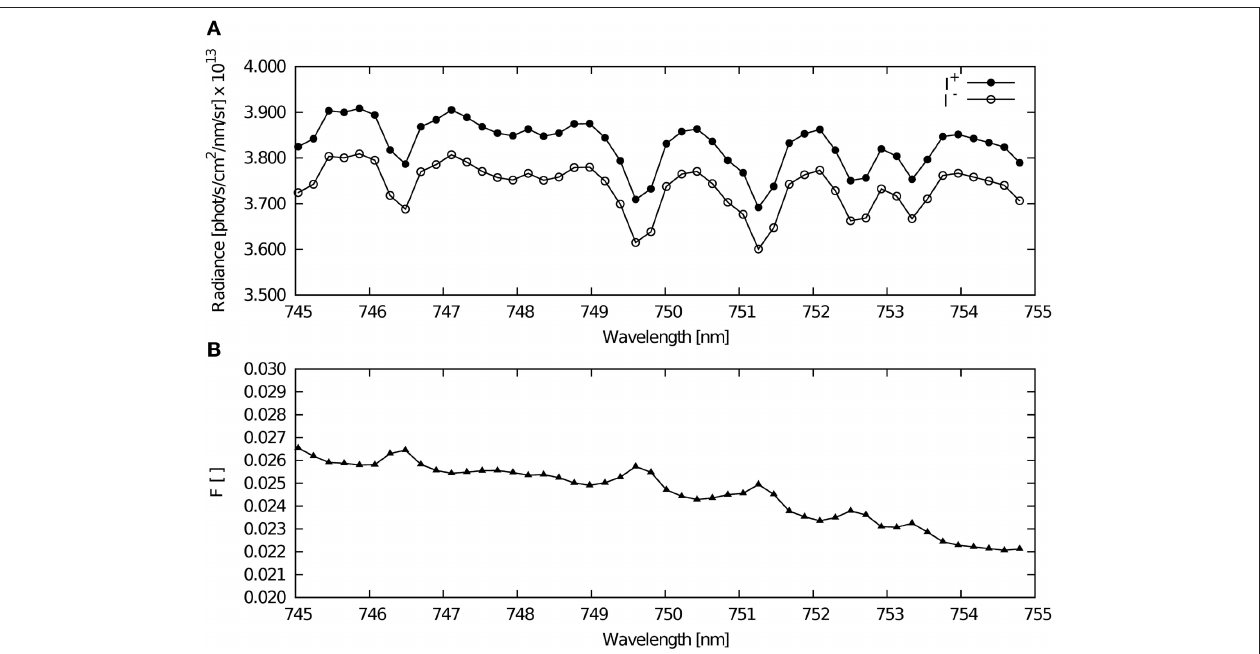
FIGURE 1 | Example of basic radiance spectra used in this study. (A) Radiances I + and I − calculated with and without SIF contribution, respectively; (B) the FR spectrum F calculated according to Equation (5) and radiances shown in (A)